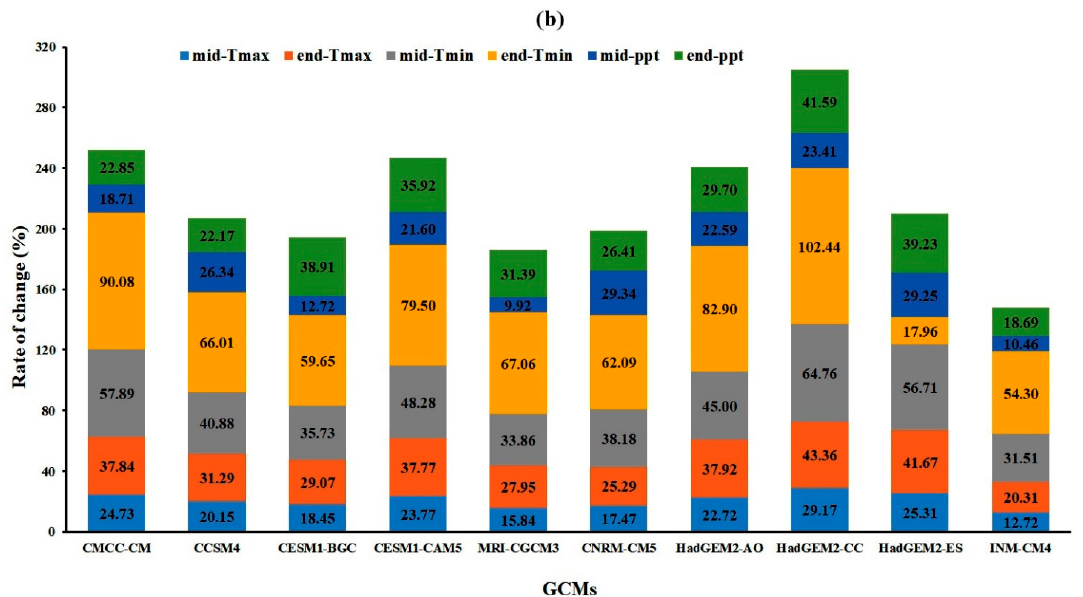
Figure 5. Projected precipitation and temperature change for the 10 GCMs under ( a ) the RCP 4.5 and ( b ) RCP 8.5 scenarios for 2046–2065 (MC) and 2081–2099 (EC) from 1993–2018